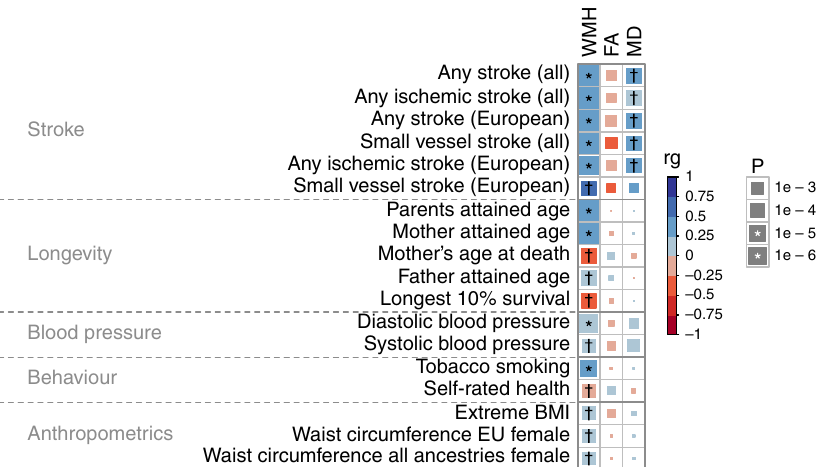
Fig. 3 Genetic correlations between WMH, FA and MD traits and other traits. The symbols * and † indicate signi fi cant correlated traits by Bonferroni and FDR multiple testing correction respectively.